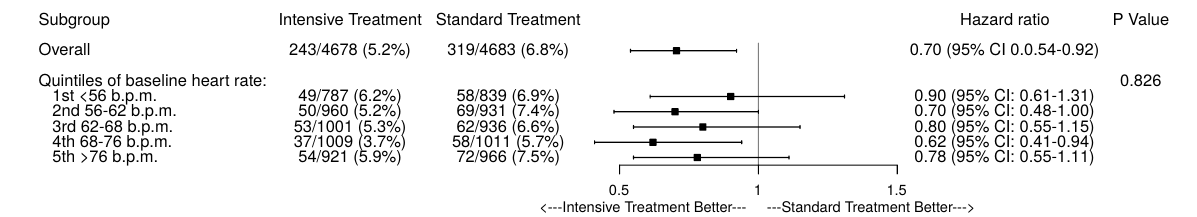
Figure 3. Benefit of intensive versus standard reduction of systolic blood pressure according to quintiles of baseline resting heart rate.